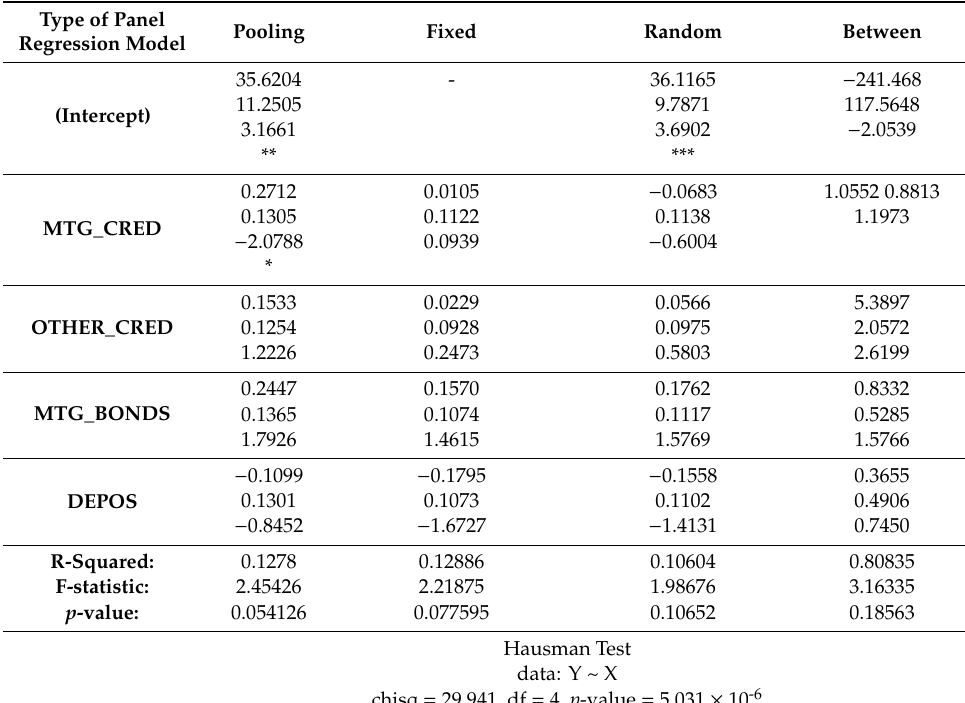
Table 6. IM ~ MTG_CRED + OTHER_CRED + MTG_BONDS + DEPOS. (Balanced Panel: n = 8, T = 9, N =